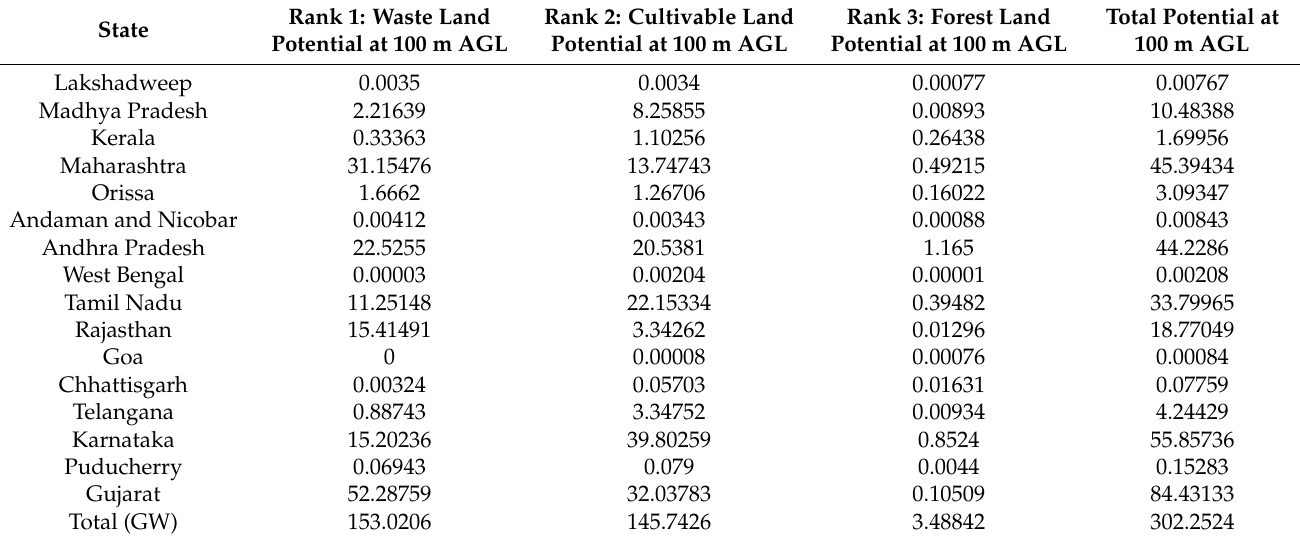
Table 14. Wind power potential in India at 100 m AGL (GW). Source: NIWE